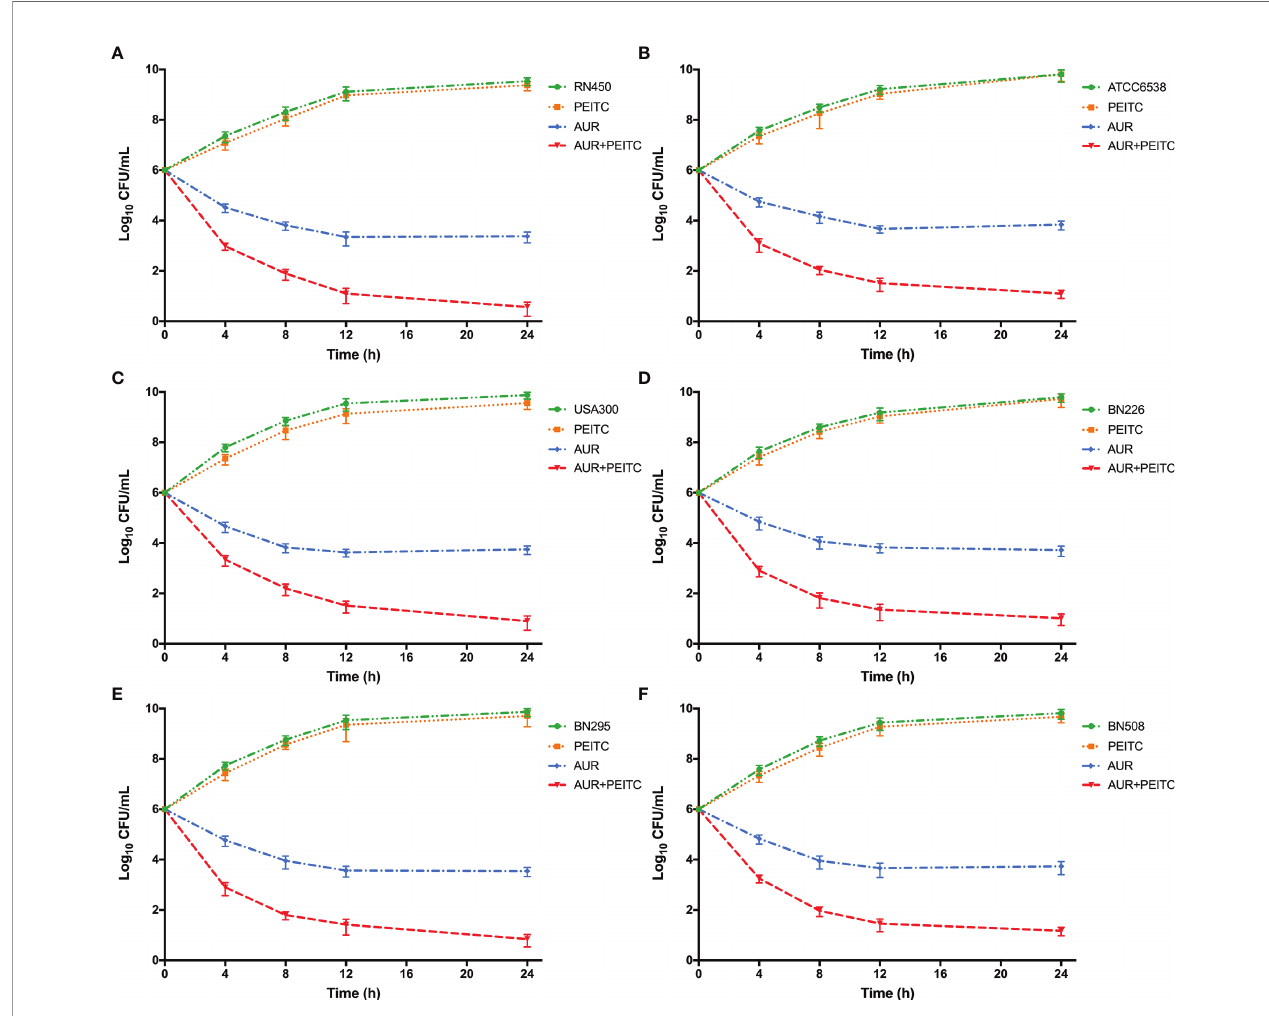
FIGURE 3 | The synergistic killing of S. aureus by AUR in combination with PEITC. Time-kill curves for 4× MIC aurano fi n (AUR) or 1× MIC phenethyl isothiocyanate (PEITC) monotherapy or their combination therapy against S. aureus during 24 h incubation. (A) S. aureus RN450, (B) S. aureus ATCC6538, (C) MRSA USA300, (D) MRSA BN226, and (E) MRSA BN295, and (F) MRSA BN508. Data are from at least three independent experiments; error bars indicate the standard errors of the means.